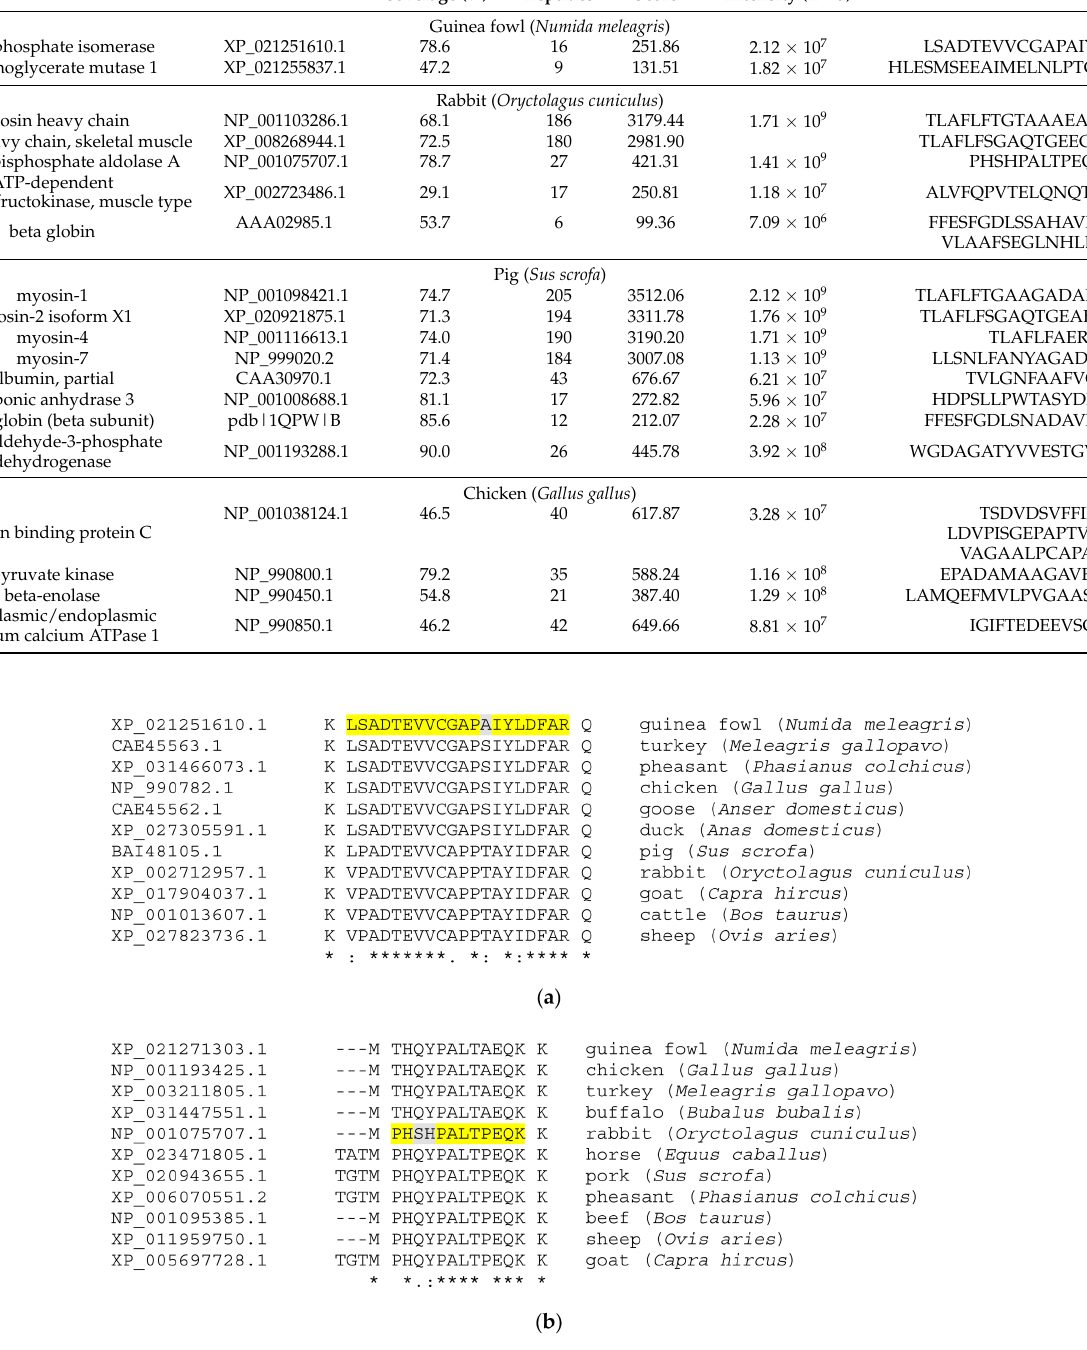
Figure 3. Clustal Omega protein multiple sequence alignment of guinea fowl- and rabbit-specific peptides: ( a ) triosephos- phate isomerase ( Numida meleagris ) sequence fragment and ( b ) fructose-bisphosphate aldolase A ( Oryctolagus cuniculus ) sequence fragment. Identified species-specific heat-stable peptide markers are highlighted. Symbols in a multiple se- quence alignment: an * (asterisk) indicates positions which have a single, fully conserved residue; a: (colon) indicates conservation between groups of strongly similar properties; a. (period) indicates conservation between groups of weakly similar